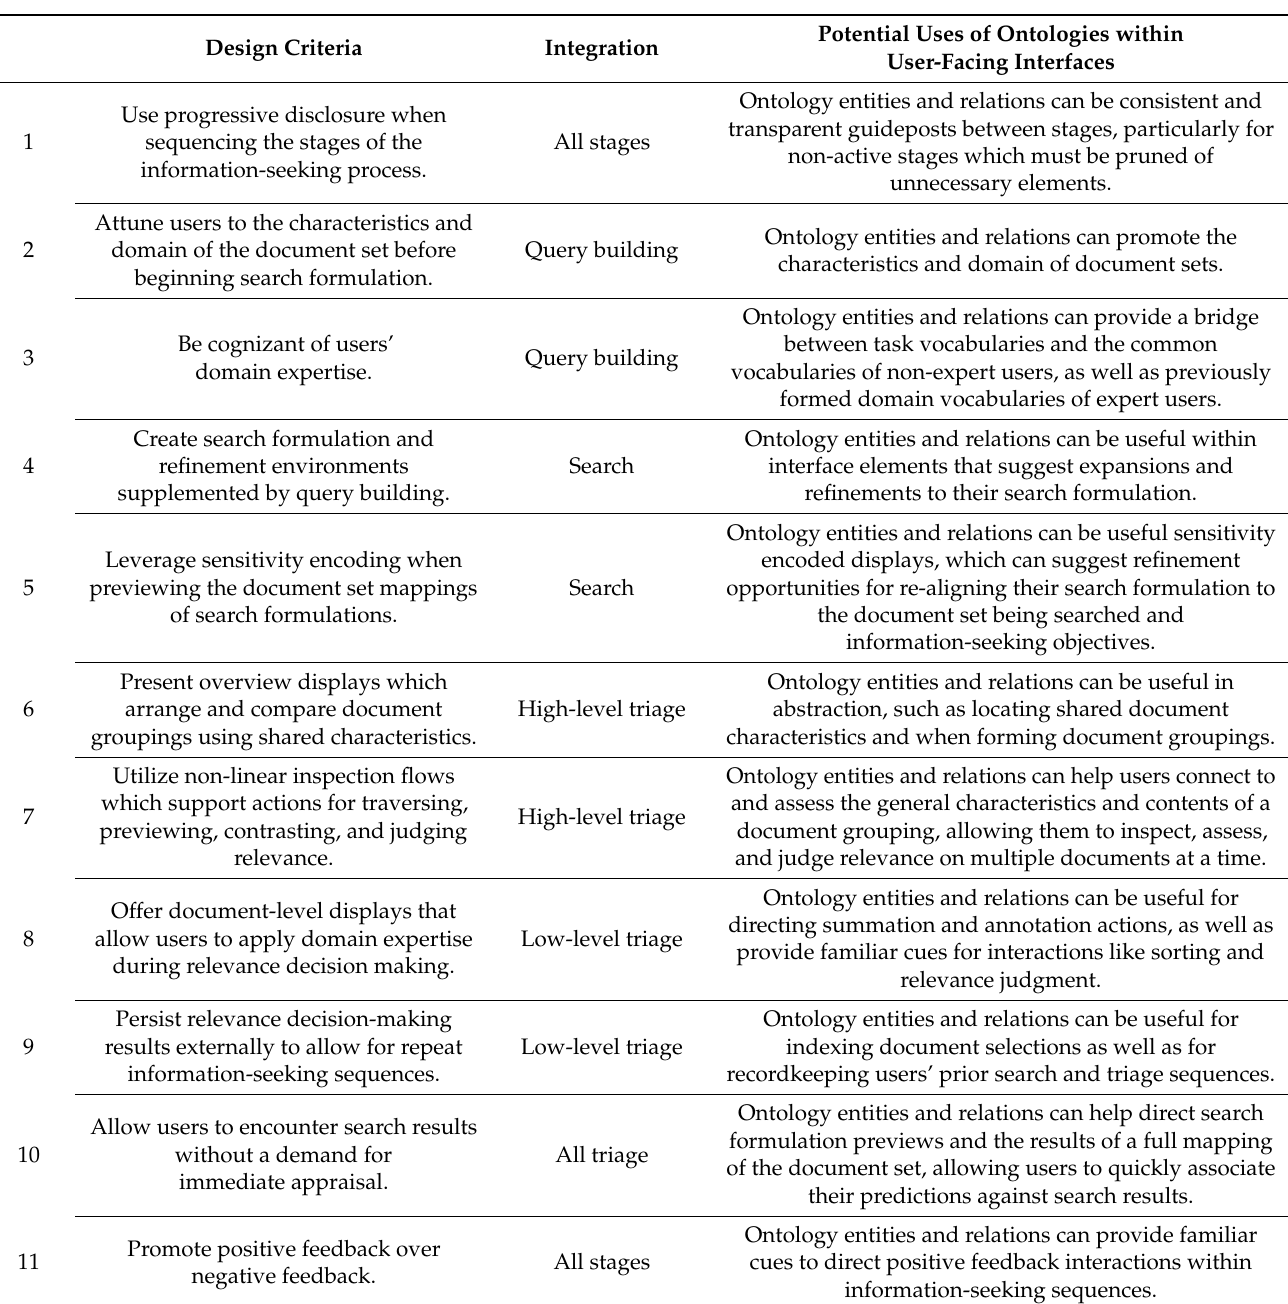
Table 3. The set of criteria for designing VAT interfaces for searching and triaging large document sets. For reference within discussion, a numerical value is assigned to each criterion. Each DC# describes the design criteria and provides an integration classification and examples of potential uses of ontologies within user-facing information seeking